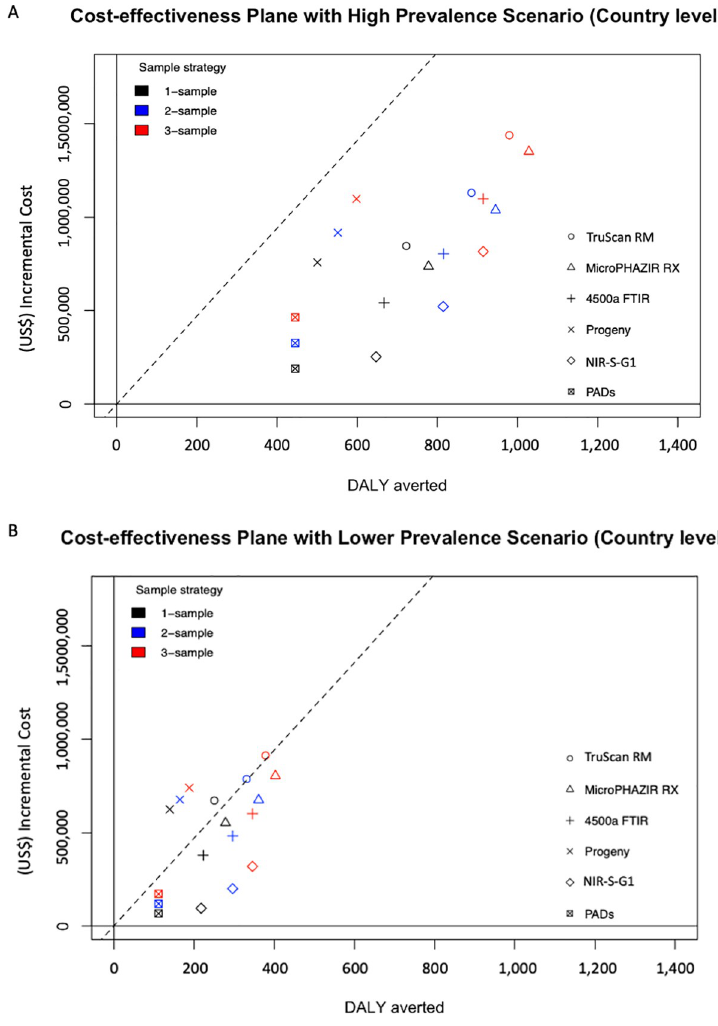
Fig 4. Incremental costs and effects of all sampling strategies (1, 2, or 3-samples per drug per inspection) under (A) high prevalence scenario and (B) lower prevalence scenario. The diagonal line represents the Willingness to pay threshold at US$ 2,353, Lao PDR GDP per